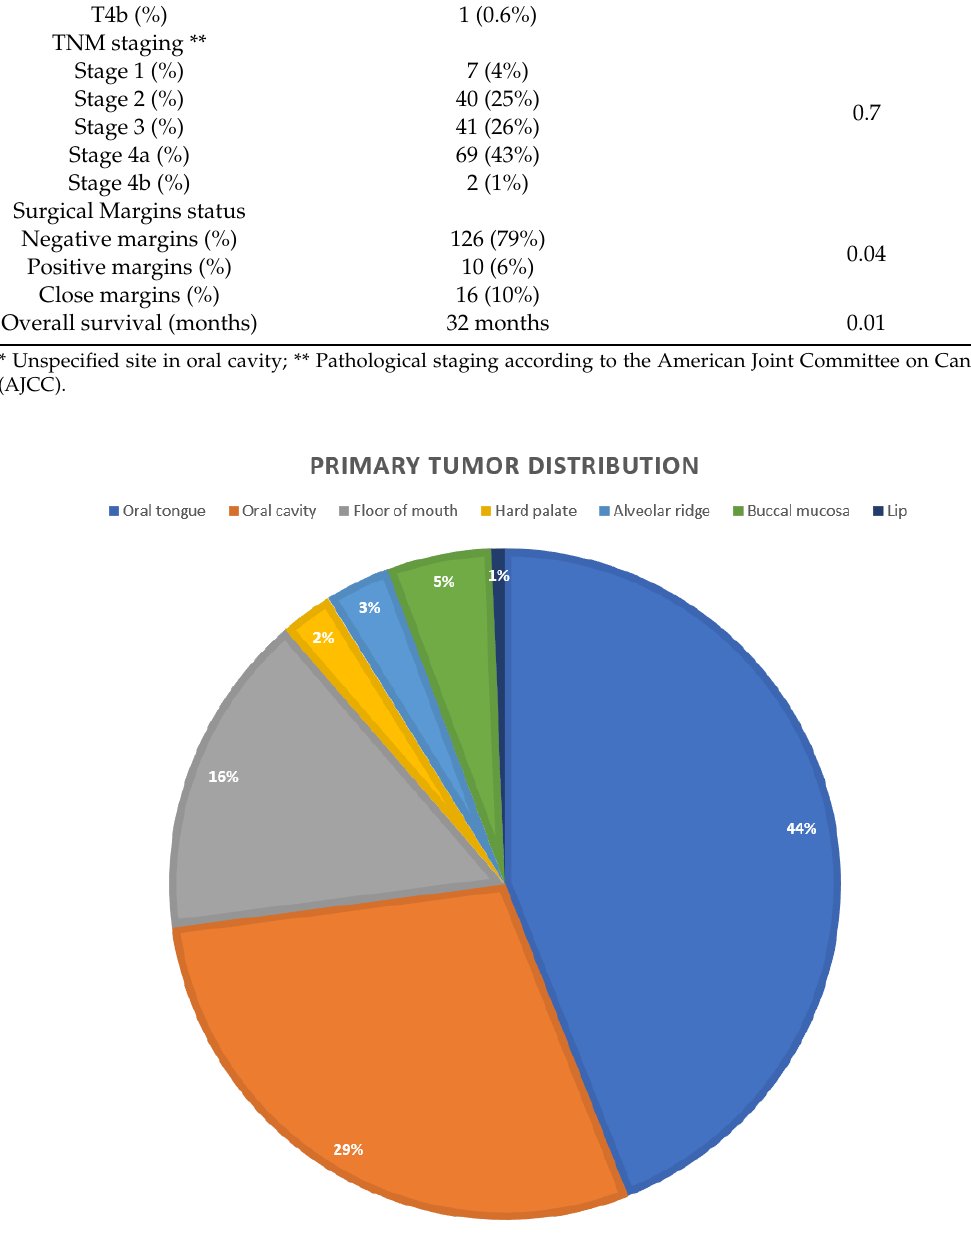
Figure 1. The primary tumor site distribution of the study cohort.